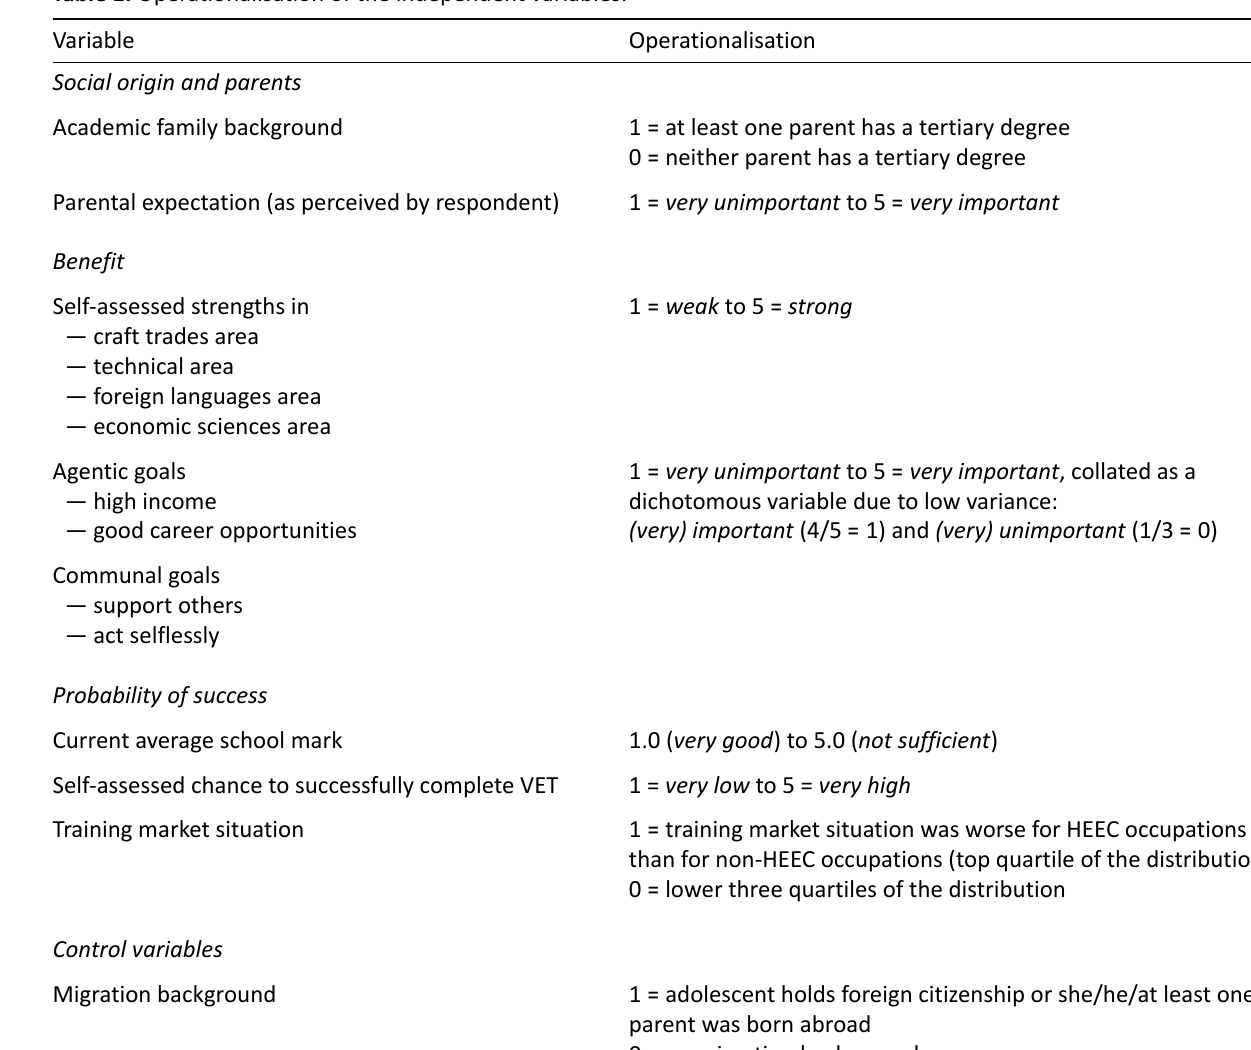
Table 1. Operationalisation of the independent